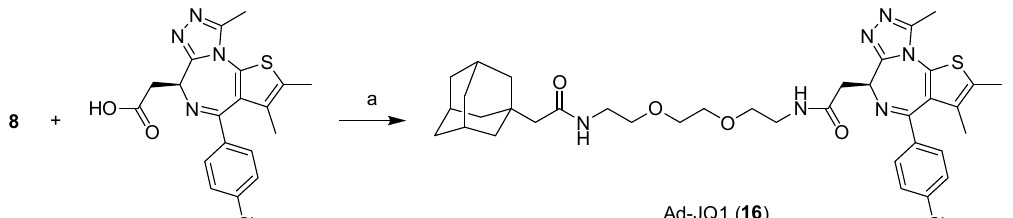
Scheme 4. (a) HBTU, DIPEA, and DMF.